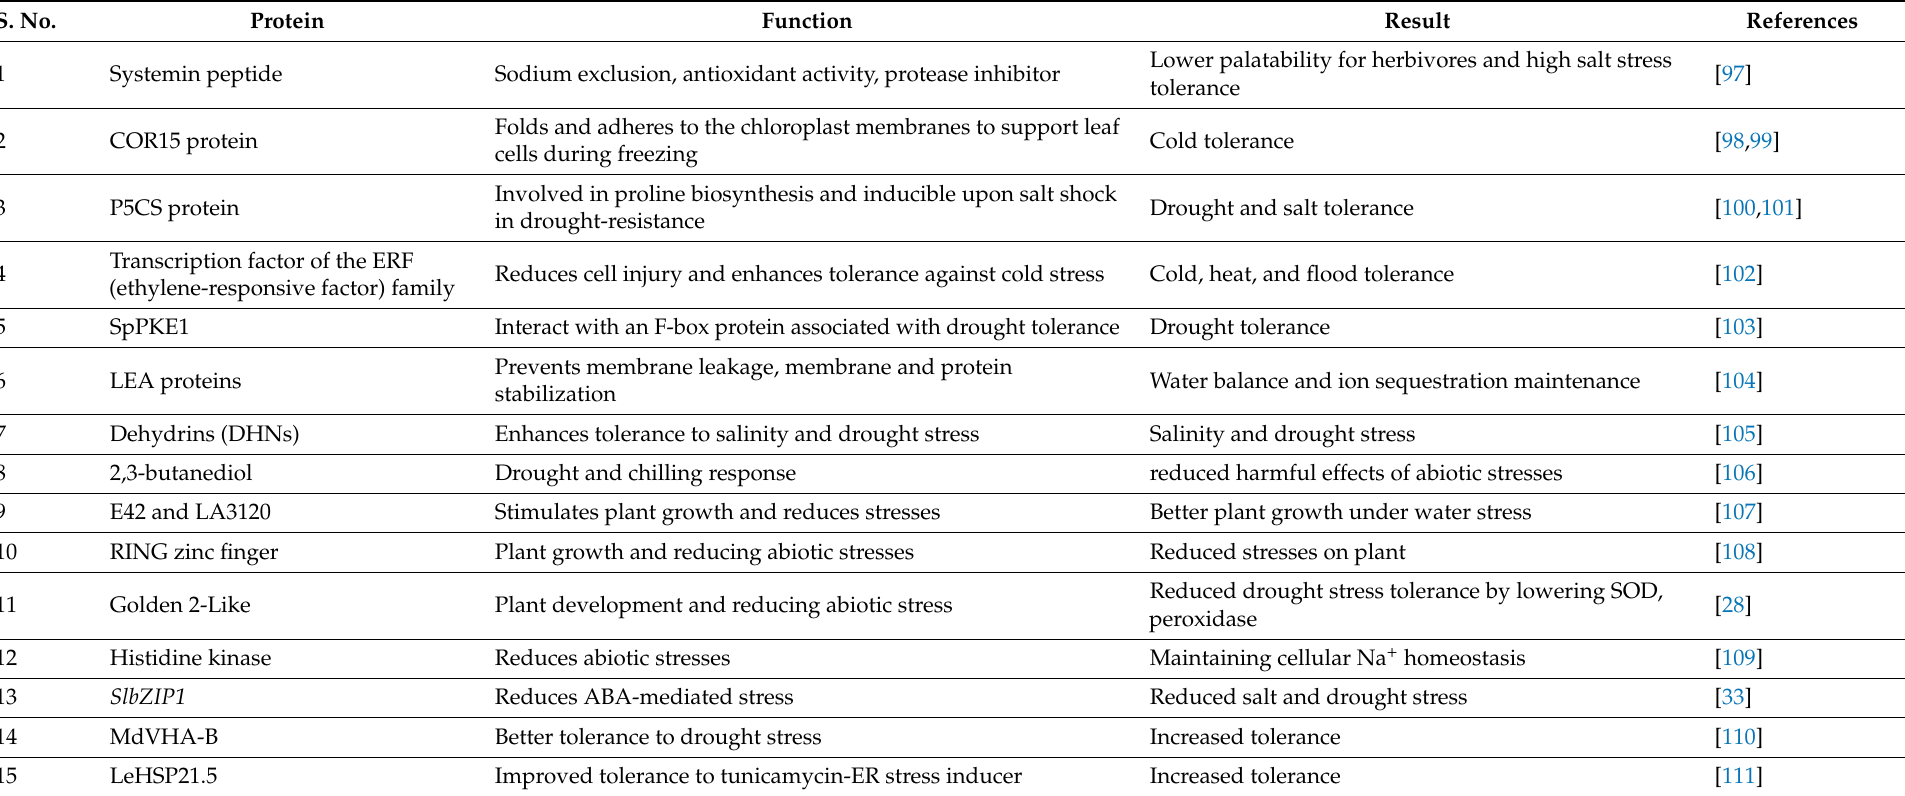
Table 2. Proteins to combat abiotic stress tolerance in